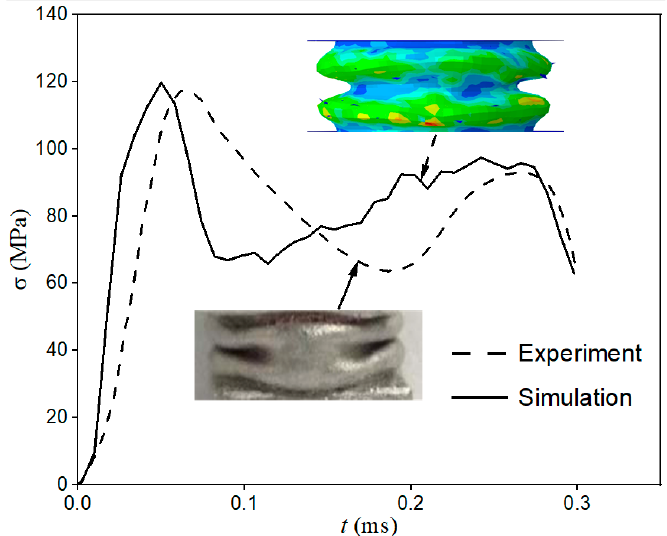
Figure 8. Stress-time curve of Fluka 100-C 8 silicone gel experiment and simulation.